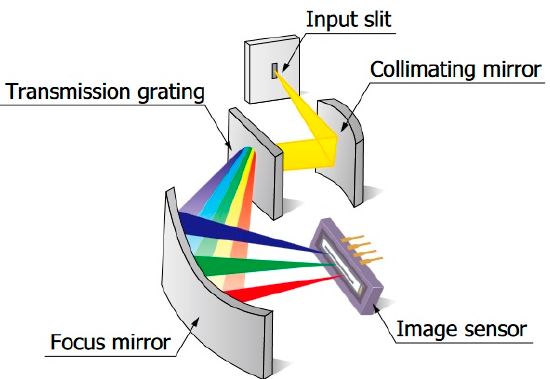
Figure 1. Sample architecture of an integrated monochromator in the mini-spectrometer [10].